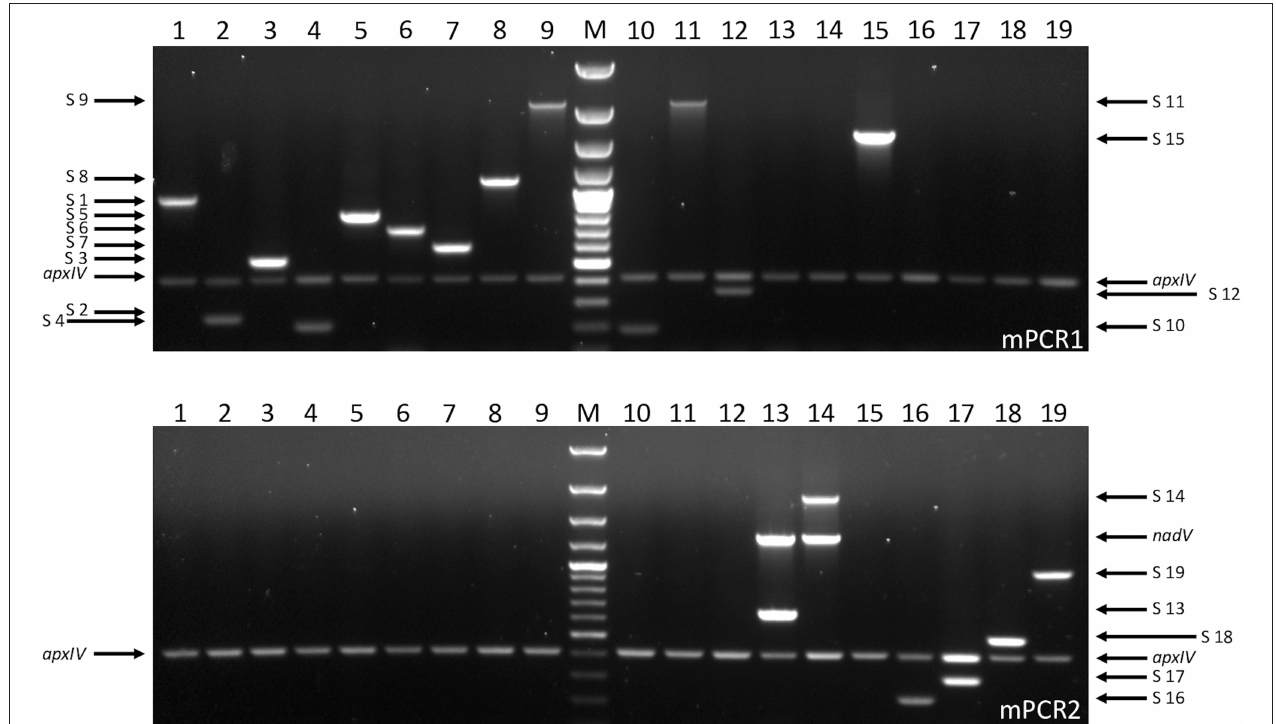
FIGURE 2 | Serovar-specific products amplified by APP-mPCR1 (upper) and APP-mPCR2 (lower) using samples from FTA ® cards inoculated with A. pleuropneumoniae reference strains for serovars 1–19 (1, 4074T; 2, S1536; 3, S1421; 4, M62; 5a, K17; 5b, L20; 6, Femø; 7, WF83; 8, 405; 9, CVJ13261; 10, D13039; 11, 56153; 12, 8329; 13, N-273; 14, 3906; 15, HS143; 16, A-85/14; 17, 16287-1; 18, 7311555; and 19, 7213384-1) at OD 600 = 0.01. An apxIV (423-bp) amplicon is detected in all 19 serovar reference strains, with an additional 1,339-bp nadV amplicon detected only in the biovar 2 isolates (lanes 13 and 14). For both gels, lane M = 100 bp Plus DNA Ladder (GeneRuler, Thermo Fisher Scientific).